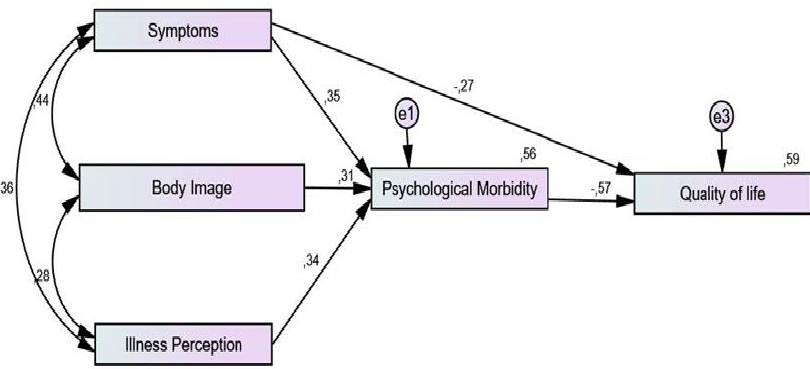
Figure 2. Final model: chi-square = 1.22; df = 2; Tucker–Lewis index = 0.991; comparative fit index = 0.998; root mean square error of approximation = 0.044.